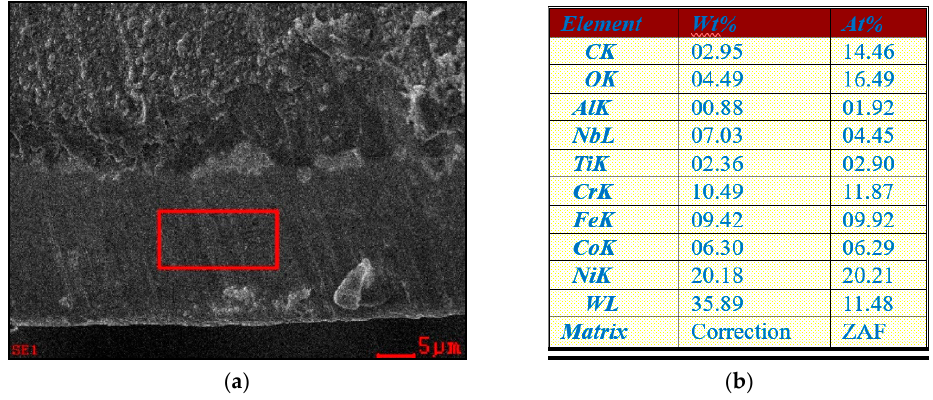
Figure 9. Energy spectrum analysis of AlTiN coated drill used. ( a ) The area of Energy spectrum. ( b ) Chemical composition in the red box in ( a ).